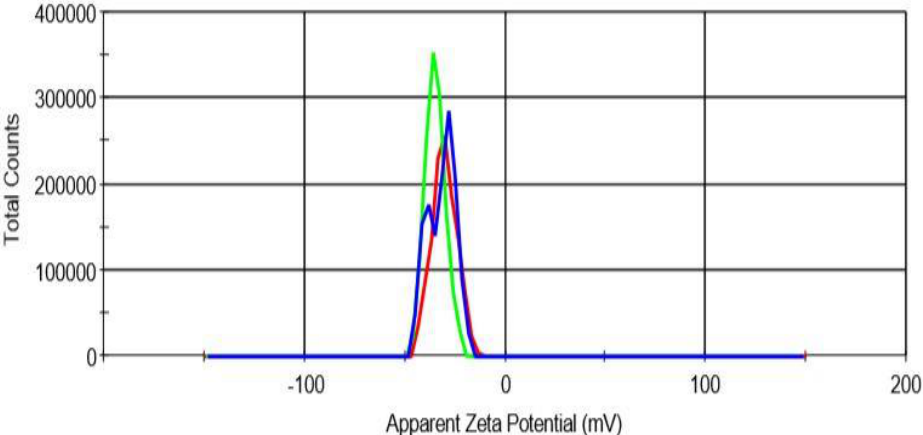
Figure 5. Zeta potential of Cur / ALG-GA NPs.